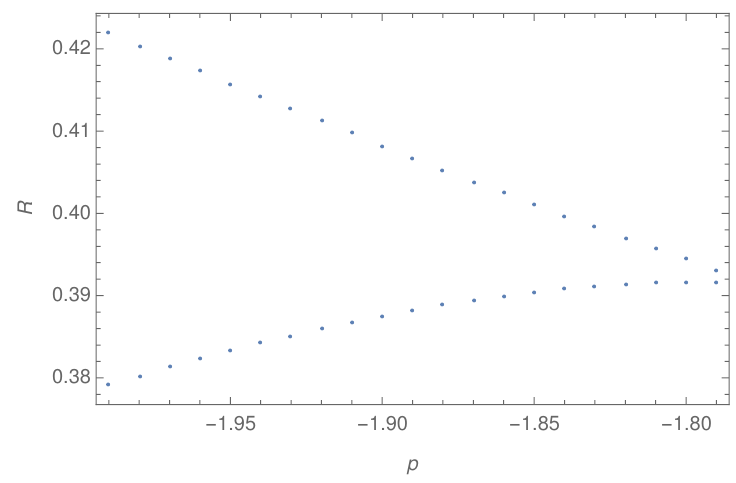
Figure 4 . The recombination factor for various values of p supporting multiple non-BPS black strings.